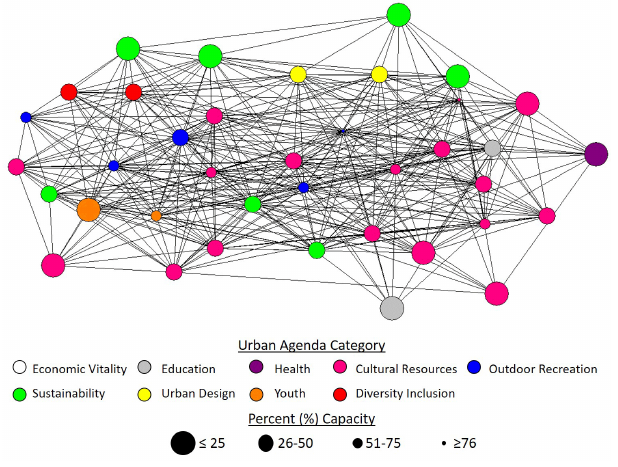
Fig. 3 . National Park Service present urban collaborative network in Boston. Actors colored by organizational category and sized by quartiles of percent capacity of all G&F brokerage roles, with larger actors representing lower percent capacity and more potential for